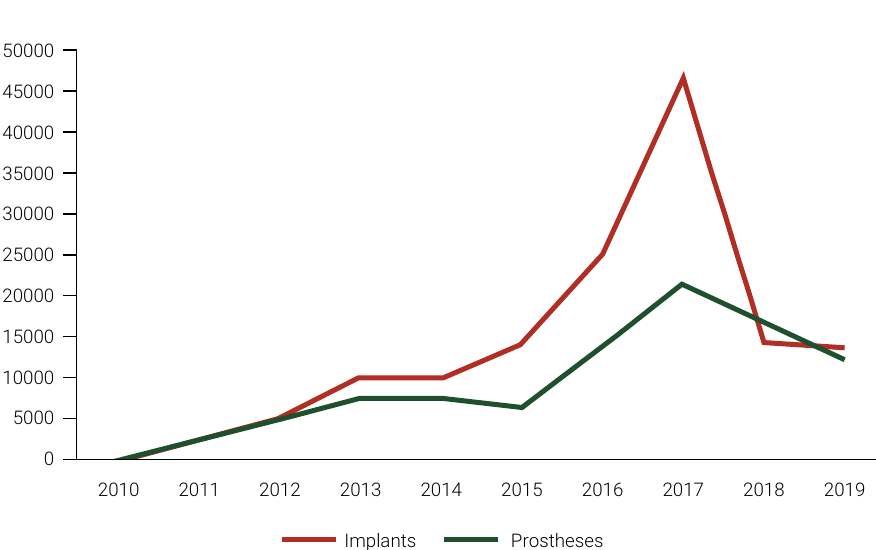
Figure 3. Number of dental implants (red line) and implant-retained prostheses (green line) provided by SUS from January 2010 to December